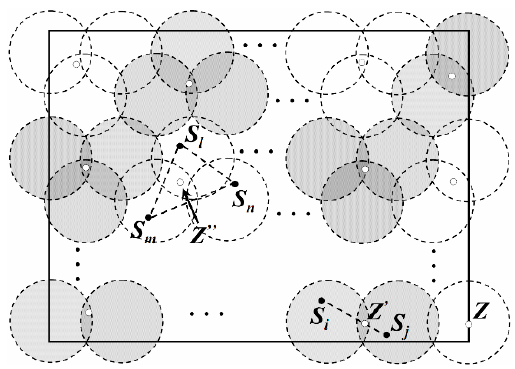
Figure 12. Location of the traverse point.